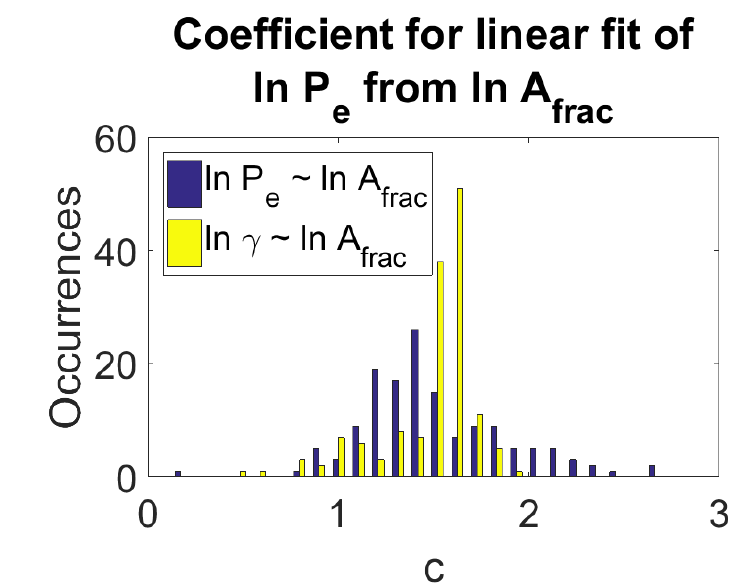
Figure 11. Histogram of the coefficients for the linear regression of lnP e ∼ lnA frac as well as ln γ el ∼ lnA frac . The coefficients correspond to c